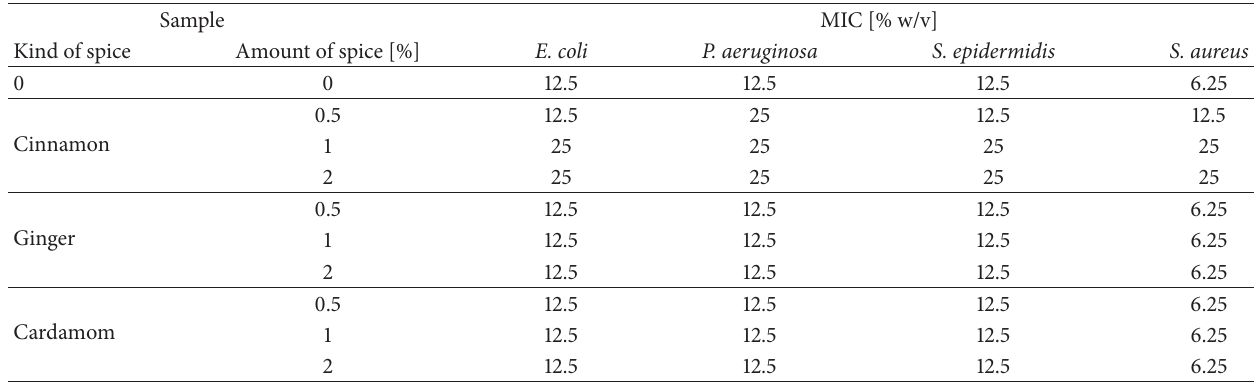
Table 2: Antimicrobial activity of investigated honey samples with spices addition.